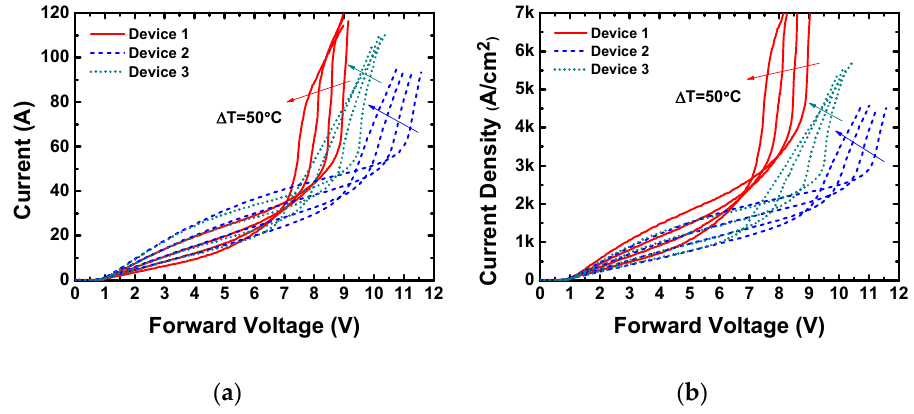
Figure 7. ( a ) The measured forward I–V characteristics of the three devices at T = 25–175 °C with a step of Δ T = 50 ℃ . ( b ) Current density–voltage (J-V) characteristics calculated from ( a ).